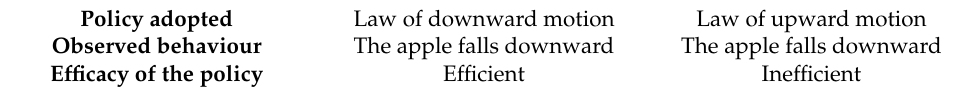
Table 1. The relationship between policies, expectations, and their observed